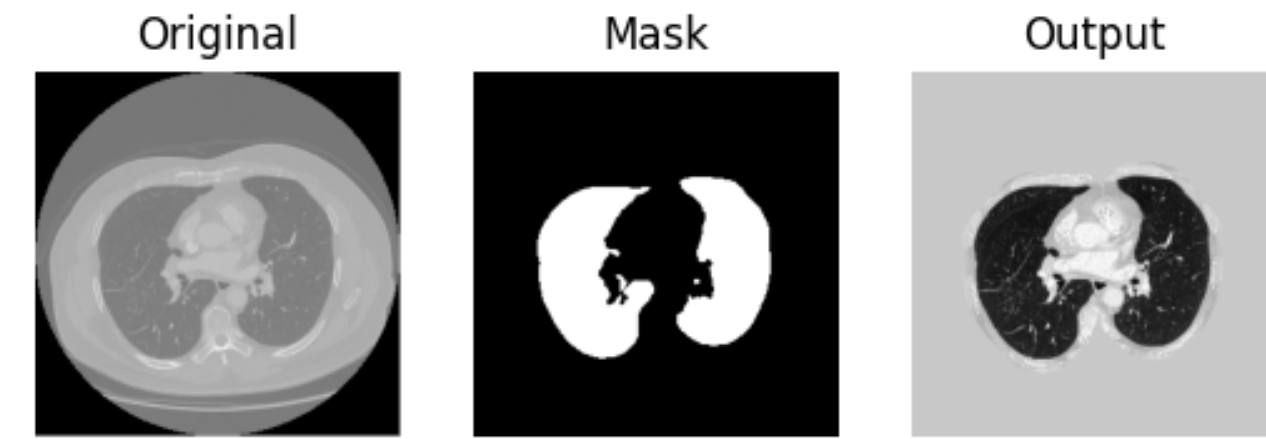
Figure 5. Data pre-processing.